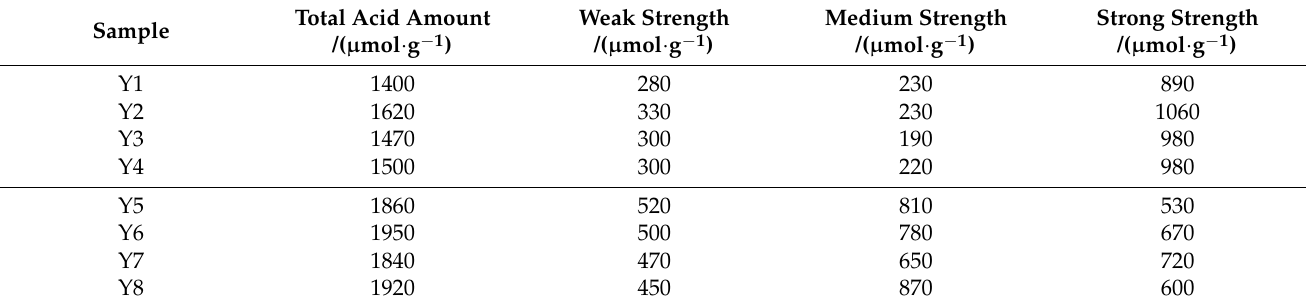
Table 2. Acid strength distribution of Y1 – Y8.